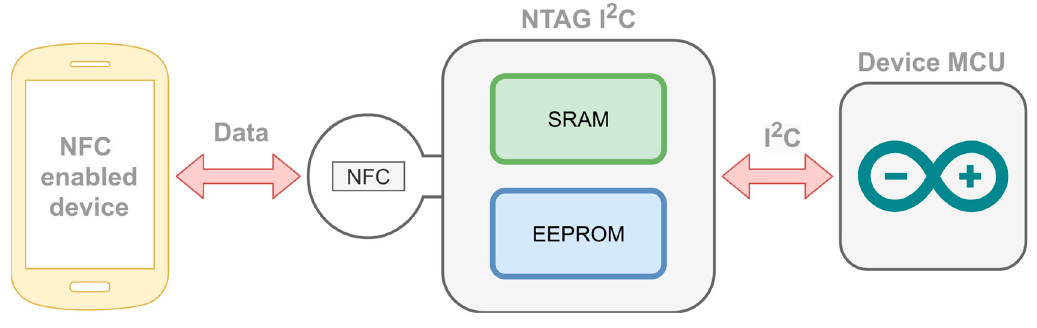
Figure 8. WiFi configuration of the device via NTAG I 2 C.